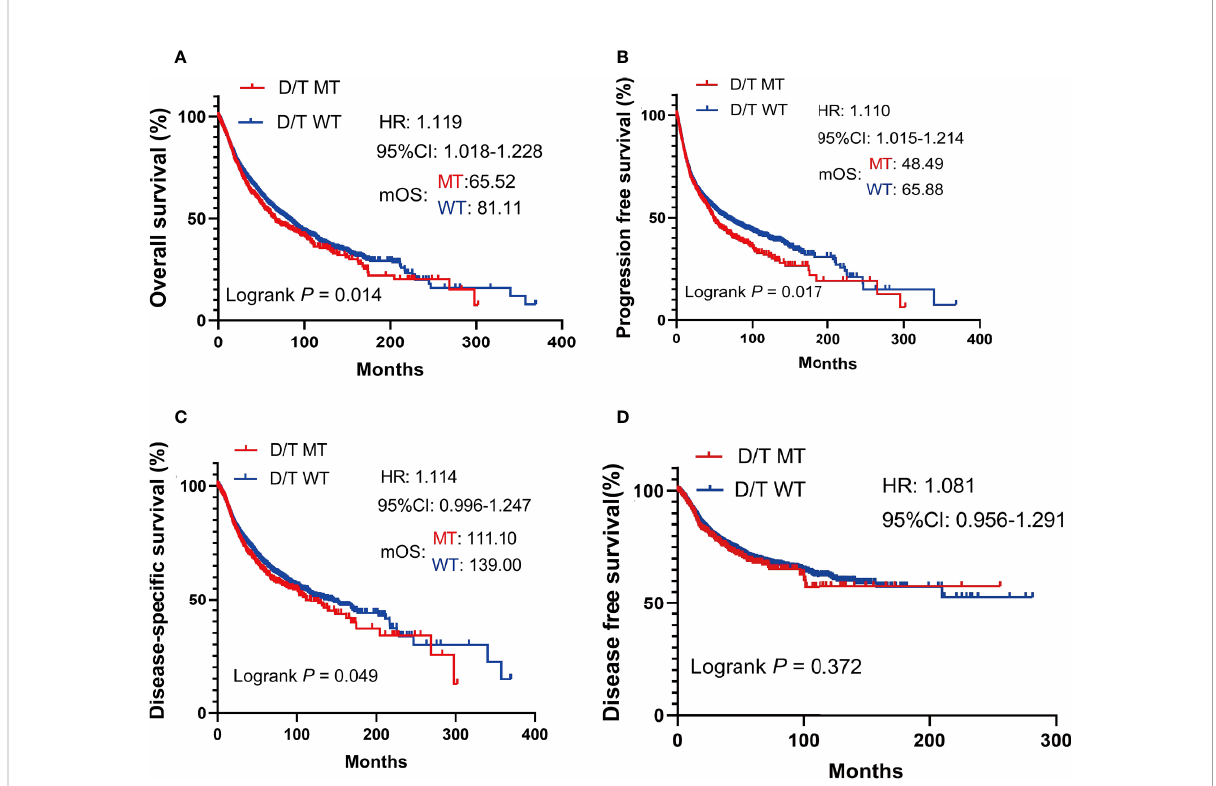
FIGURE 3 The survival signi fi cance of PTPRD/PTPRT mutation in TCGA pan-cancer cohort. Overall survival (OS) (A) , progression free survival (PFS) (B) , disease speci fi c survival (DSS) (C) , and disease-free survival (DFS) (D) analysis were performed using the TCGA pan-cancer cohort according to PTPRT/PTRTD mutation